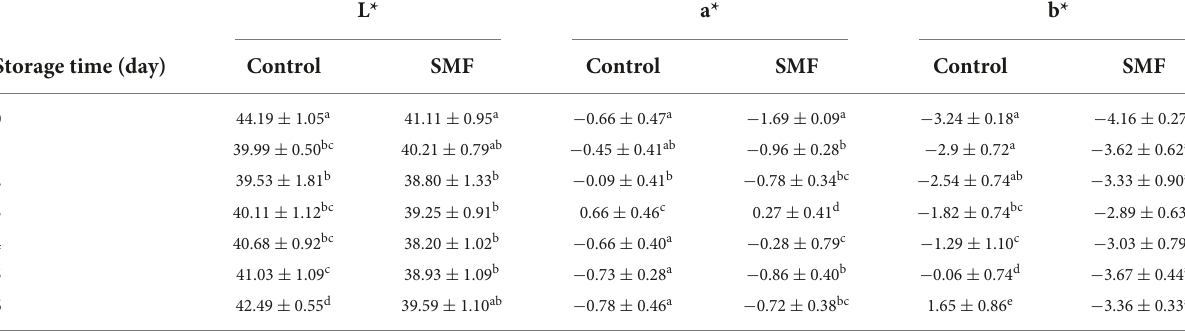
TABLE 1 Effect of static magnetic field on color of the sea bass fillet during cold storage at 4 ◦